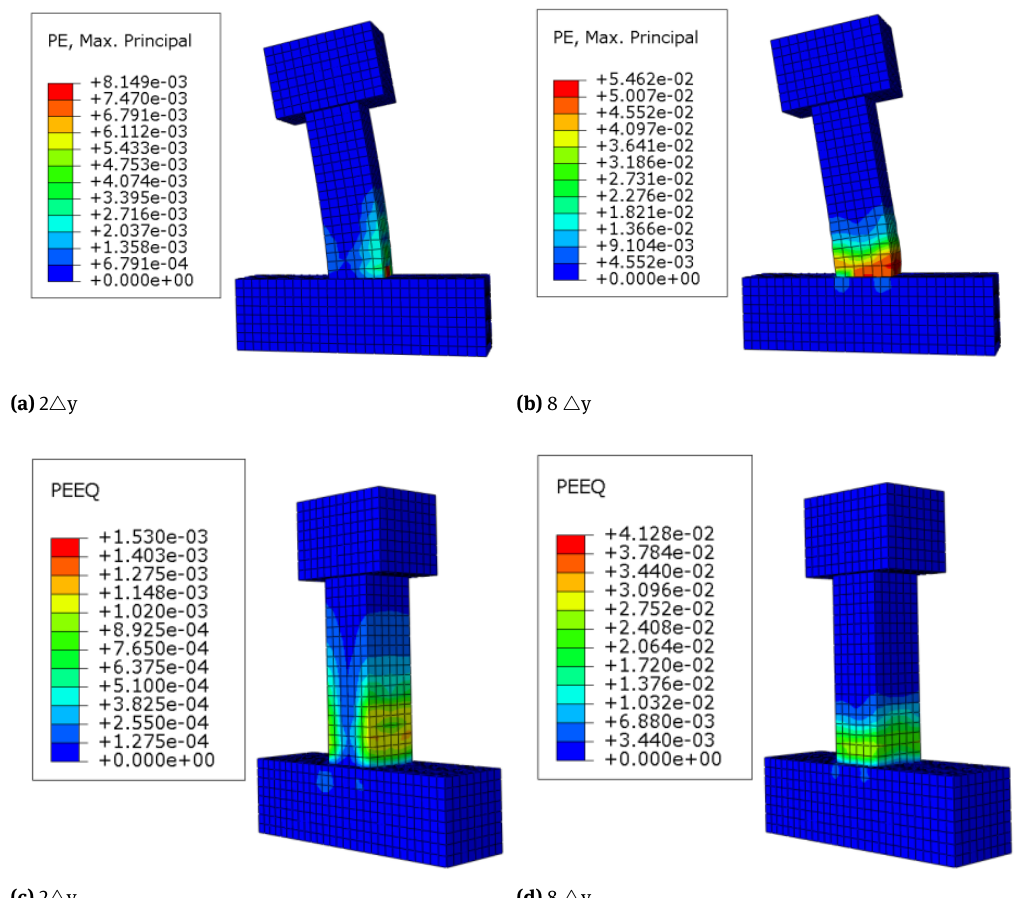
Figure 6: Nephograms of Equivalent Plastic Strain and Maximum Principal Plastic Strain of C0